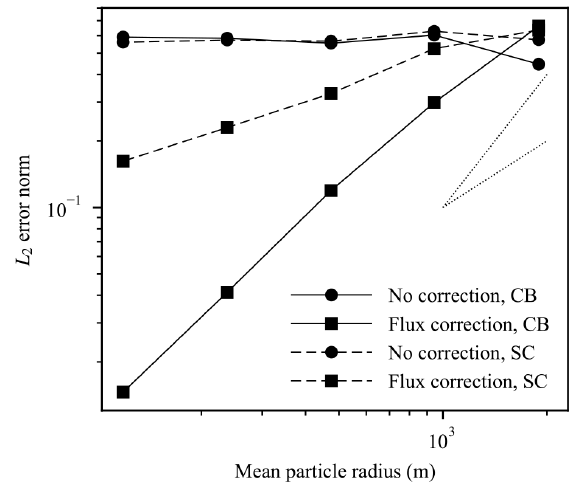
Figure 10. L 2 error norm versus mean particle radius for the cosine bell (CB) and slotted cylinder (SC) stationary two-dimensional test cases with randomized orientations with both low- and higher-order remapping. First- and second-order convergence gradients are also shown as the dotted